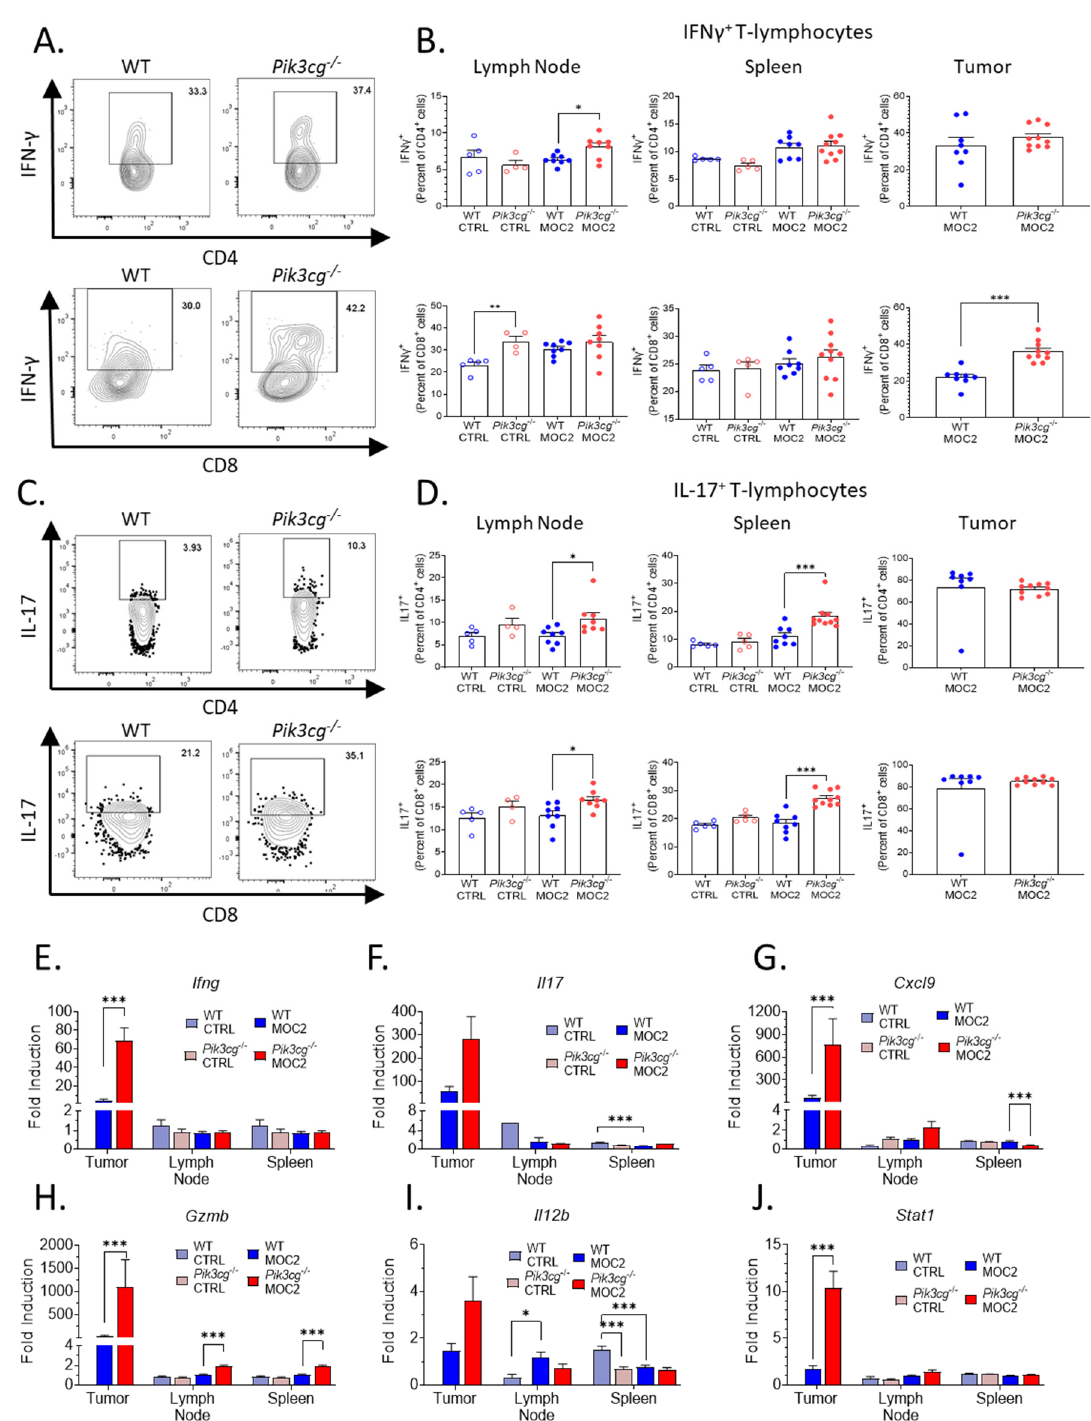
Figure 3. Host PI3K γ inhibition augments the anti-tumor CD8+ T-cell response to poorly immunogenic experimental HNSCC. ( A ) Flow cytometry gating for CD4 + IFN- γ + T-cells and CD8 + IFN- γ + T-cells. ( B ) Population frequencies of CD4 + IFN- γ + T-cells and CD8 + IFN- γ + T-cells among parent T-cell populations in the lymph node, spleen, and tumor. ( C ) Flow cytometry gating for CD4 + IL-17 + T-cells and CD8 + IL-17 + T-cells. ( D ) Population frequencies of CD4 + IL-17 + T-cells and CD8 + IL-17 + T-cells among parent T-cell populations in the lymph node, spleen and tumor. ( E – J ) Expression of ( E ) Ifng , ( F ) Il17, ( G ) Cxcl9 , ( H ) Gzmb , ( I ) Il12b , ( J ) Stat1 within the sentinel lymph nodes, spleens, and tumors of experimental mice determined by RT-qPCR. * p -value < 0.05; ** p -value < 0.01; *** p -value < 0.005 between groups, as determined by Student’s t